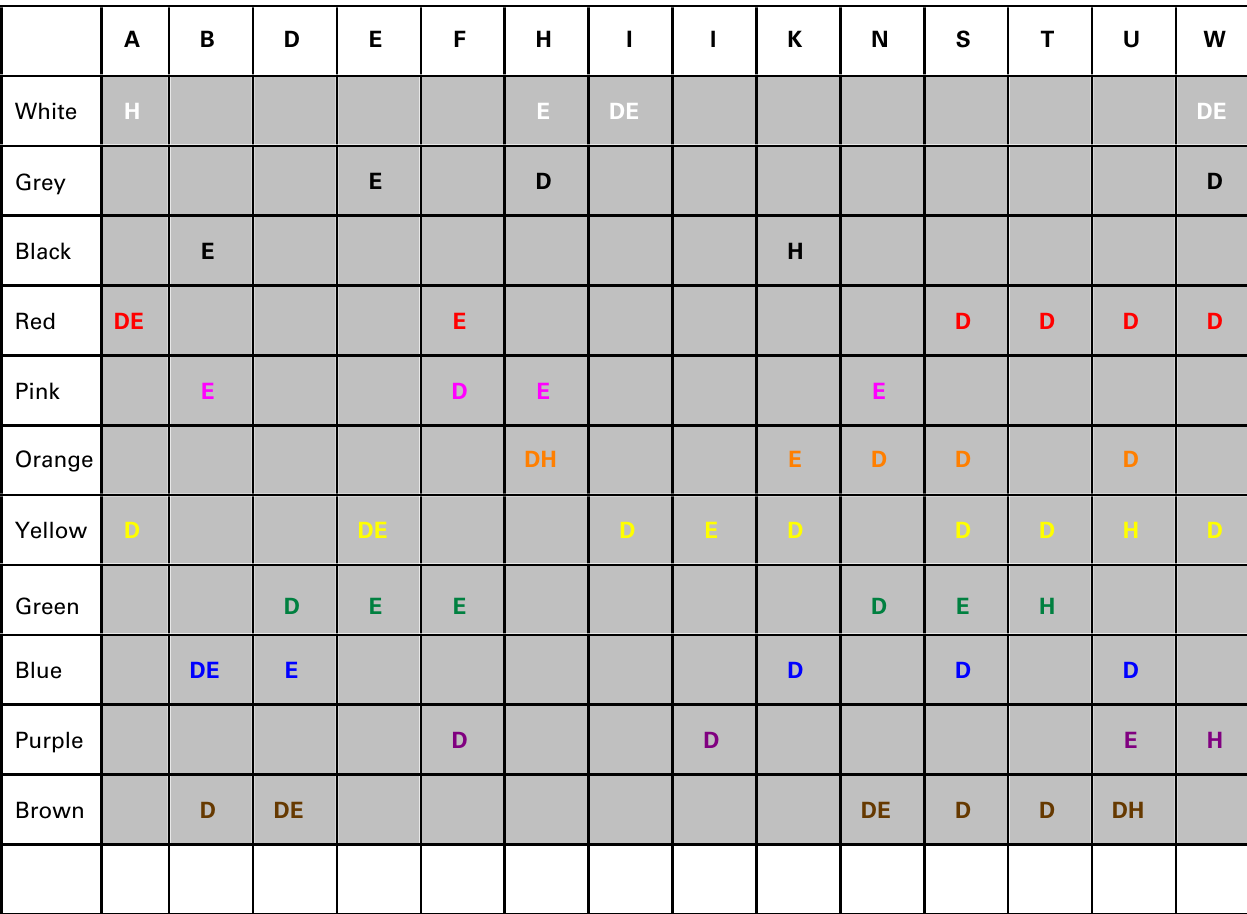
Table 5 | Colors for each of the letters that were significantly different from expected values (in a chi-test), in the Dutch (D) English (E) and Hindi (H) speaking participant